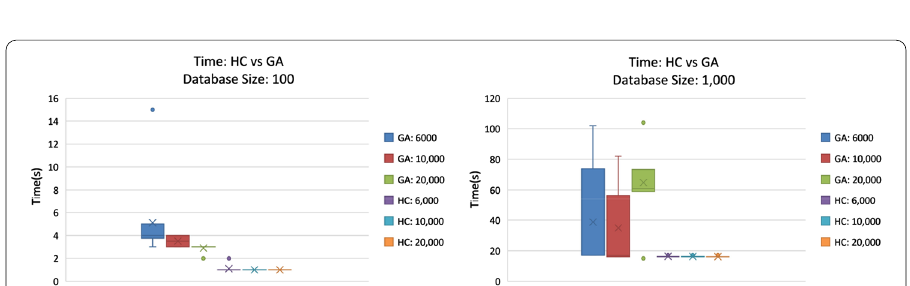
Fig. 4 Genetic Algorithm and Hill Climber: Compares GC (Population: 25) Times against HC Times